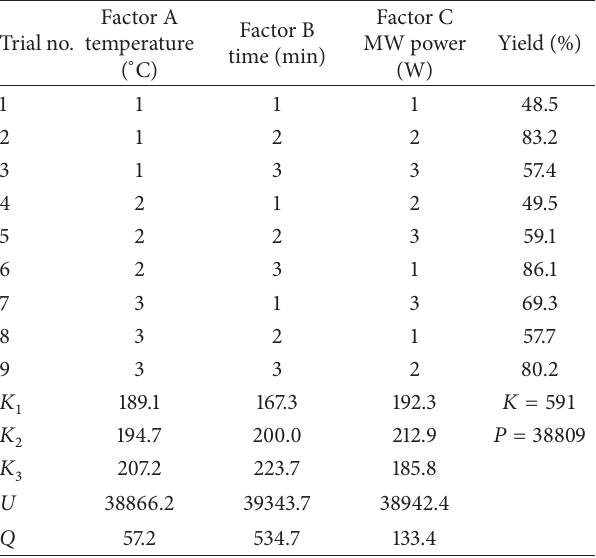
Table 8: Orthogonal experiment on synthesis of isopropyl 𝛽 -(3,4- dihydroxyphenyl)- 𝛼 -hydroxypropanoate.